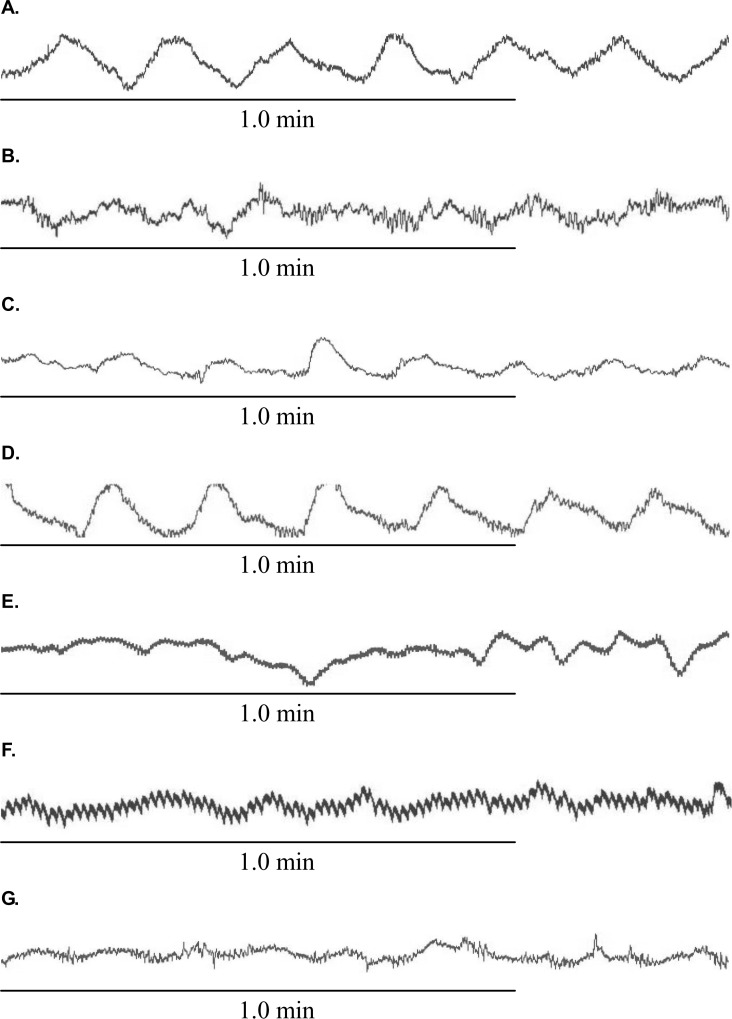
Typical GSW tracings in the fed state at different sessions.(A) GSW on baseline. (B) GSW at RD session. (C) GSW at RD+AEA session. (D) GSW at RD+EA session. (E) GSW at RD+sham AEA session. (F) GSW at RD+atropine session. (G) GSW at RD+atropine+AEA session.